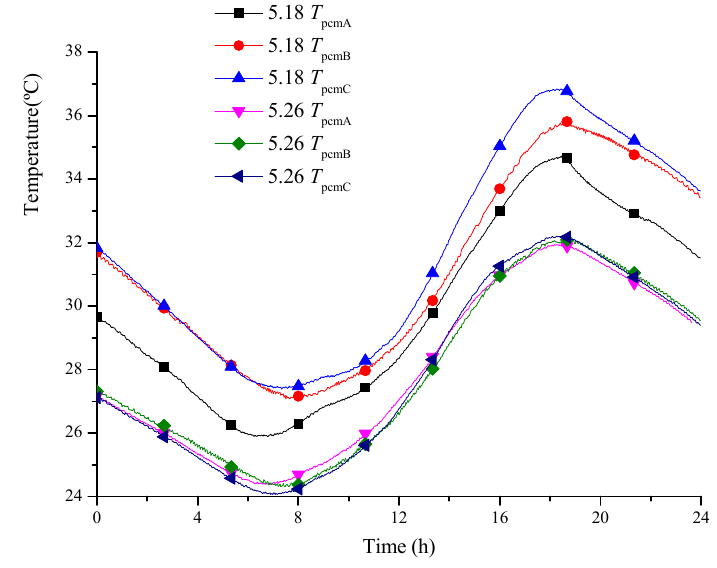
Figure 13. Temperature comparison of the PCM plate. Table 5. Temperature comparison of the PCM plate.